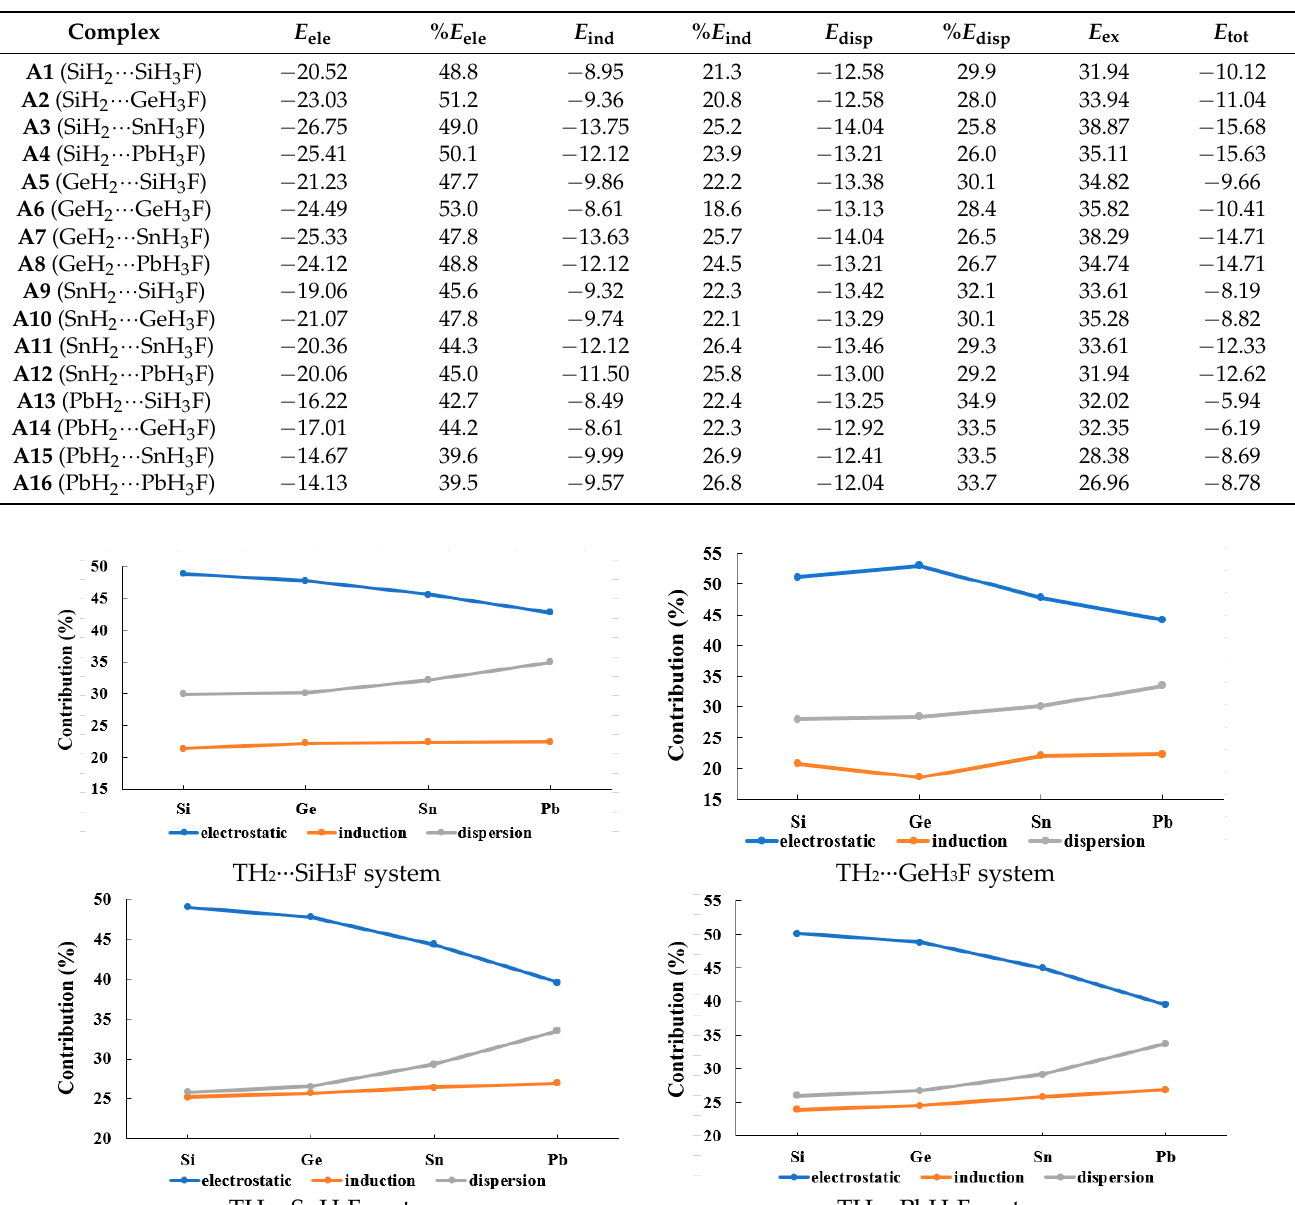
Table 3. Decomposition of the total interaction energy (Etot) for type-A complexes into electrostatic (Eele), induction (Eind), dispersion (Edisp), and exchange (Eex) energy terms. All energies in kJ/mol. The relative values in percent represent the contribution of electrostatic, induction, and dispersion energy terms to the sum of all the three energy terms.